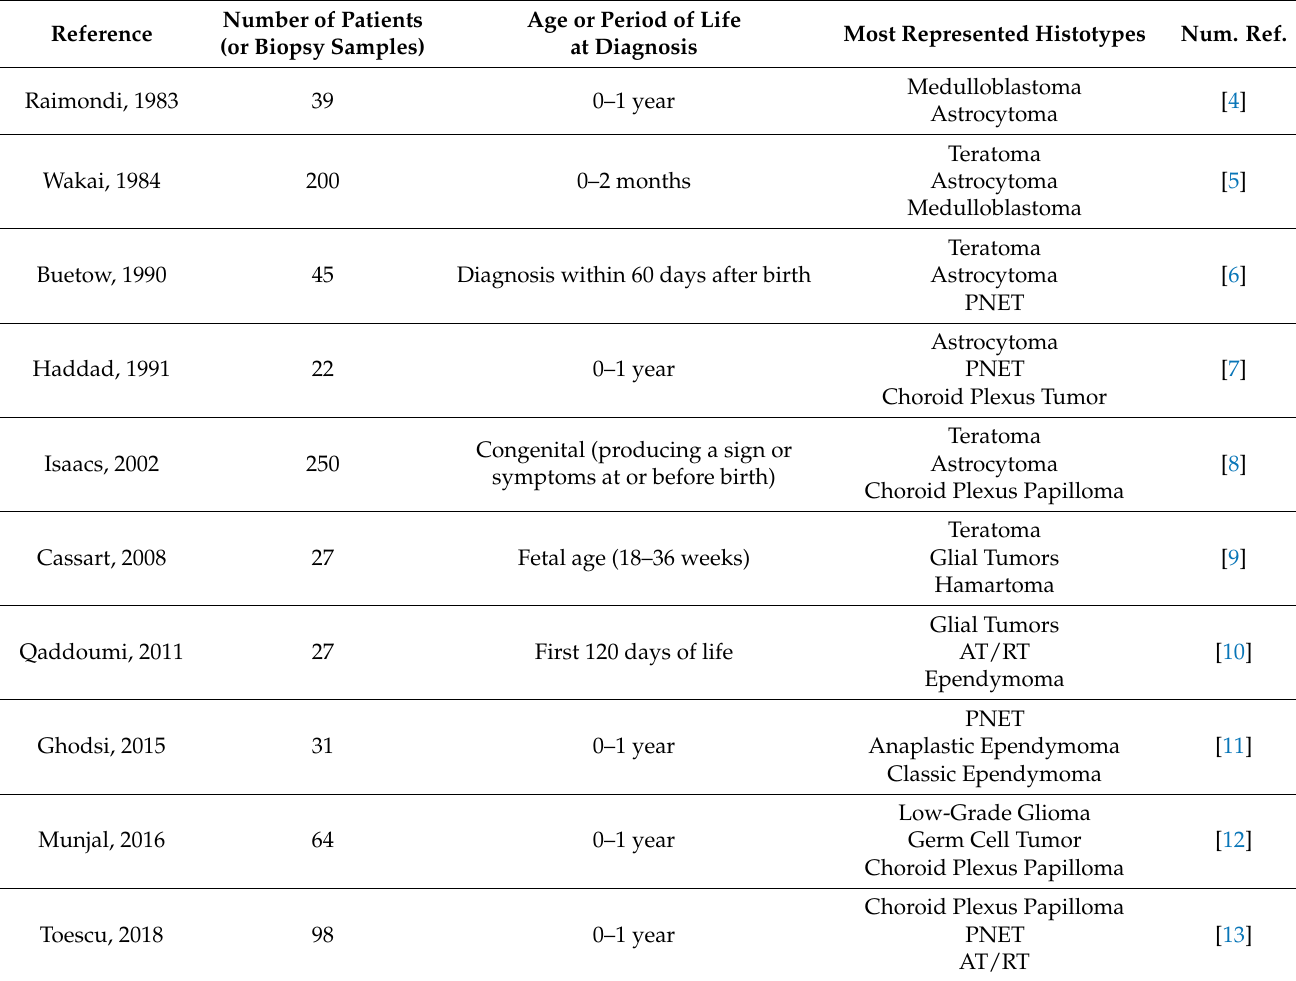
Table 1. Retrospective studies or epidemiological surveys concerning intracranial tumors in